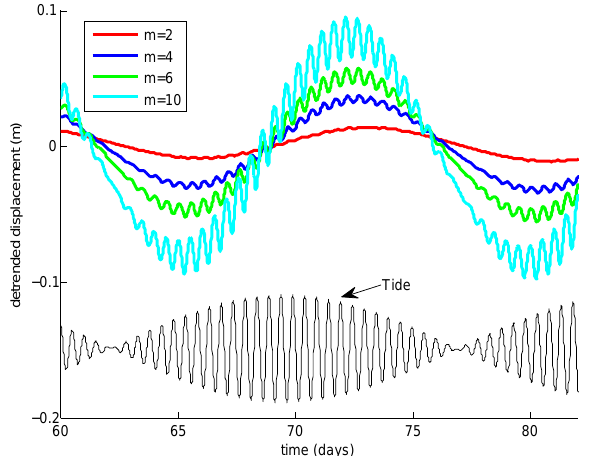
Fig. 8. Detrended displacements 30km upstream from the ground- ing line as a function of time for a number of different m values (coloured curves). Model geometry and rheological parameter val- ues other than those of the till are all identical to those used in Fig. 4 and are described in text. The black curve is the tidal amplitude scaled by a factor of 100. Tidal forcing is applied at the S2 and the M2 frequencies only and each tidal constituent has an amplitude of